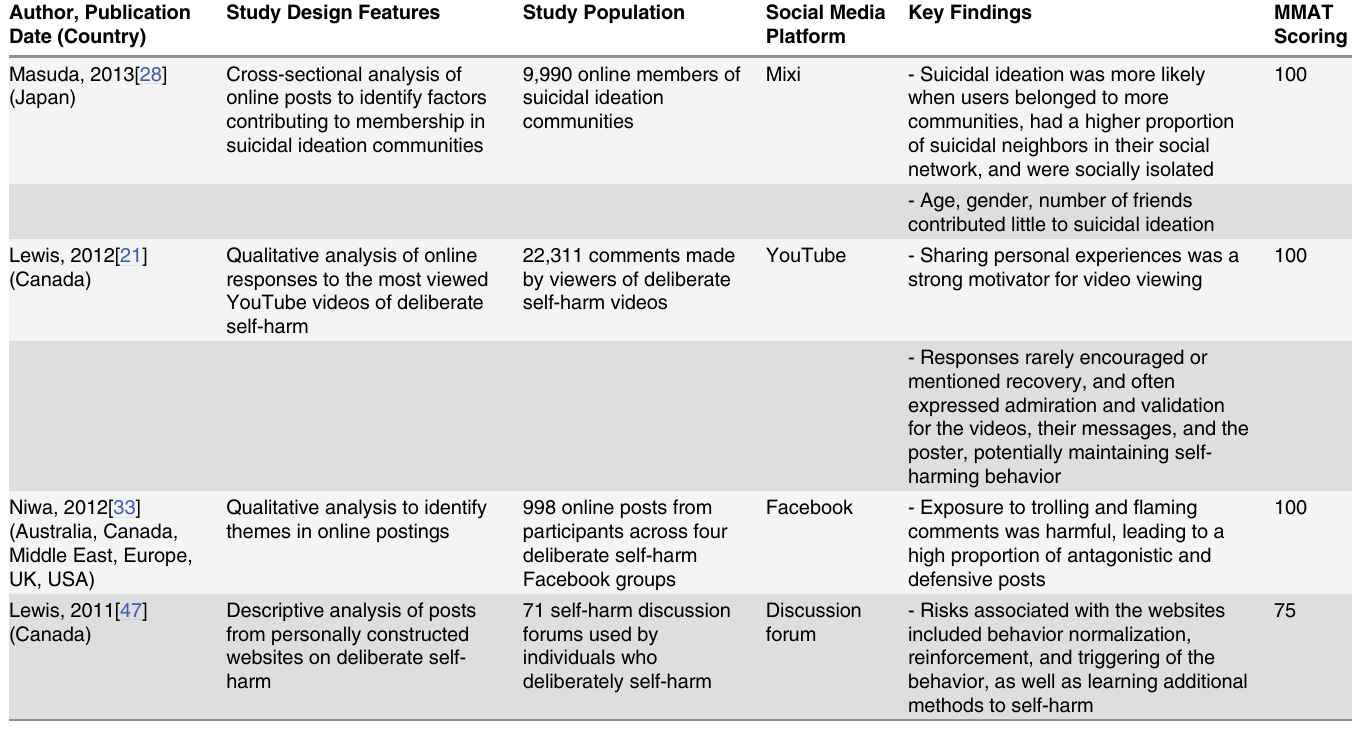
Table 4. Potential harms reported in primarily negative studies regarding the use of social media platforms to discuss and view deliberate self- harm